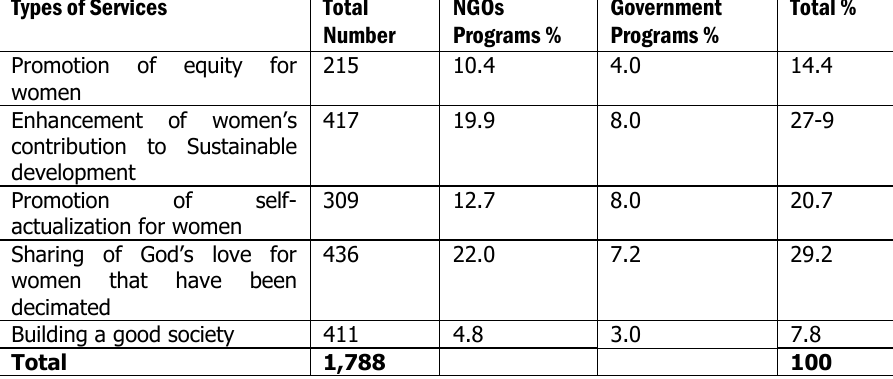
Table 5B: Respondent Rating of the Services that Government and NGOs Provided Types of